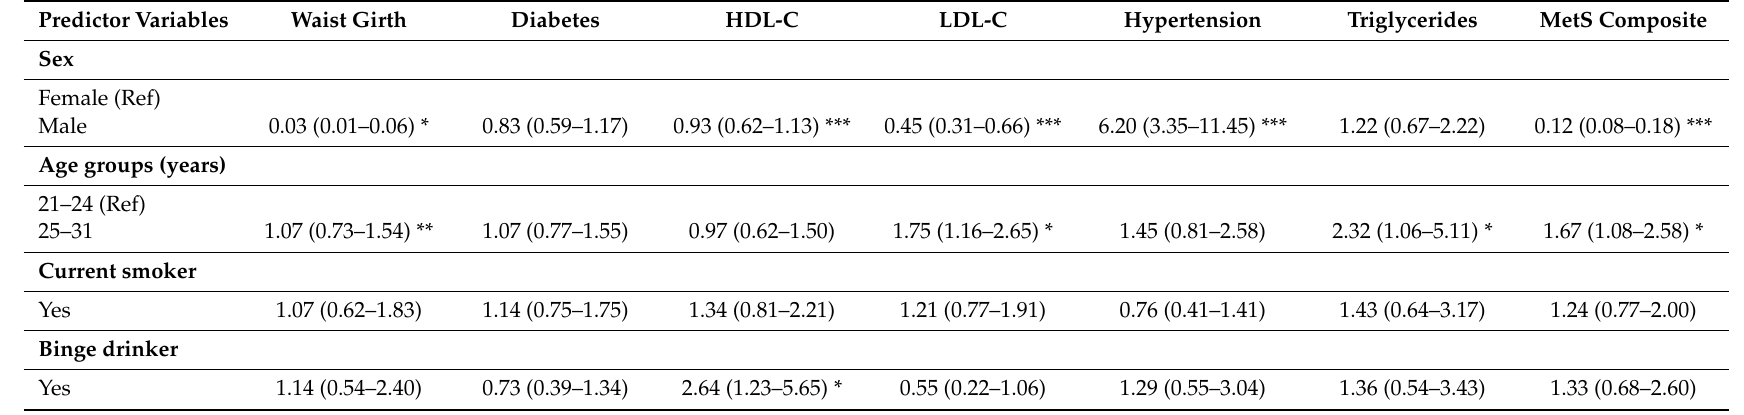
Table 4. Adjusted associations between binge drinking, related factors, and components of metabolic syndrome among Ellisras young adults aged 21 to 31